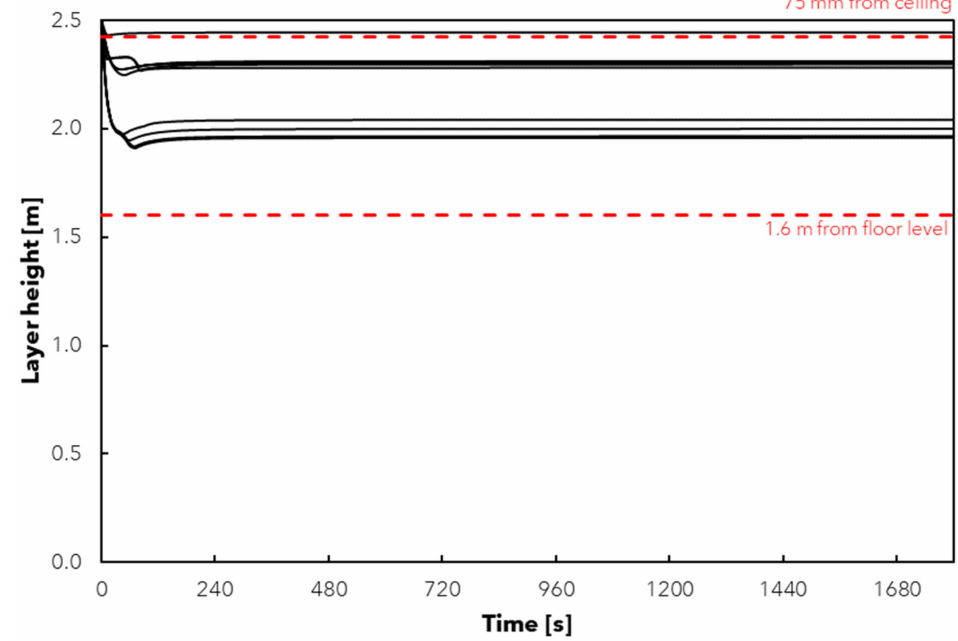
Figure 10. Layer heights estimated in the zone model simulations for a sprinkler-controlled